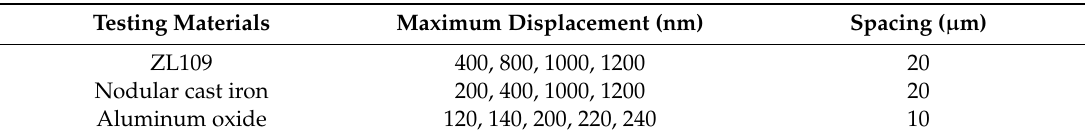
Table 3. Testing parameters of